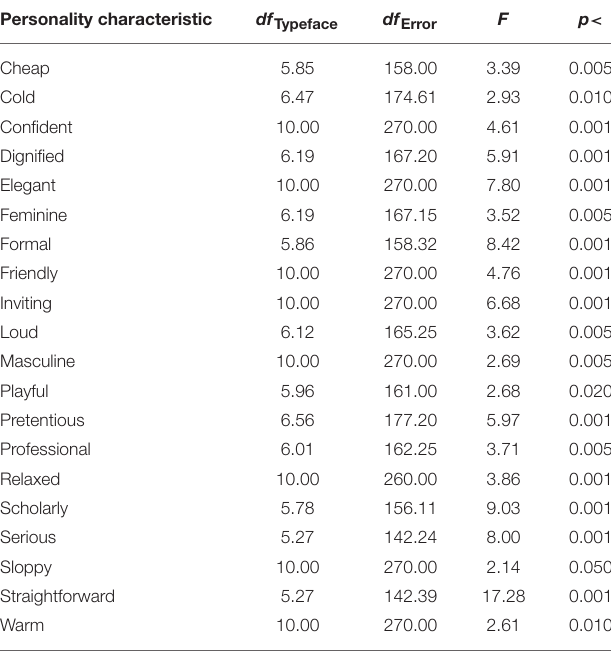
TABLE 4 | Results of analyses of variance comparing the ratings of each personality characteristic across the typefaces. Personality characteristic df Typeface df Error F p